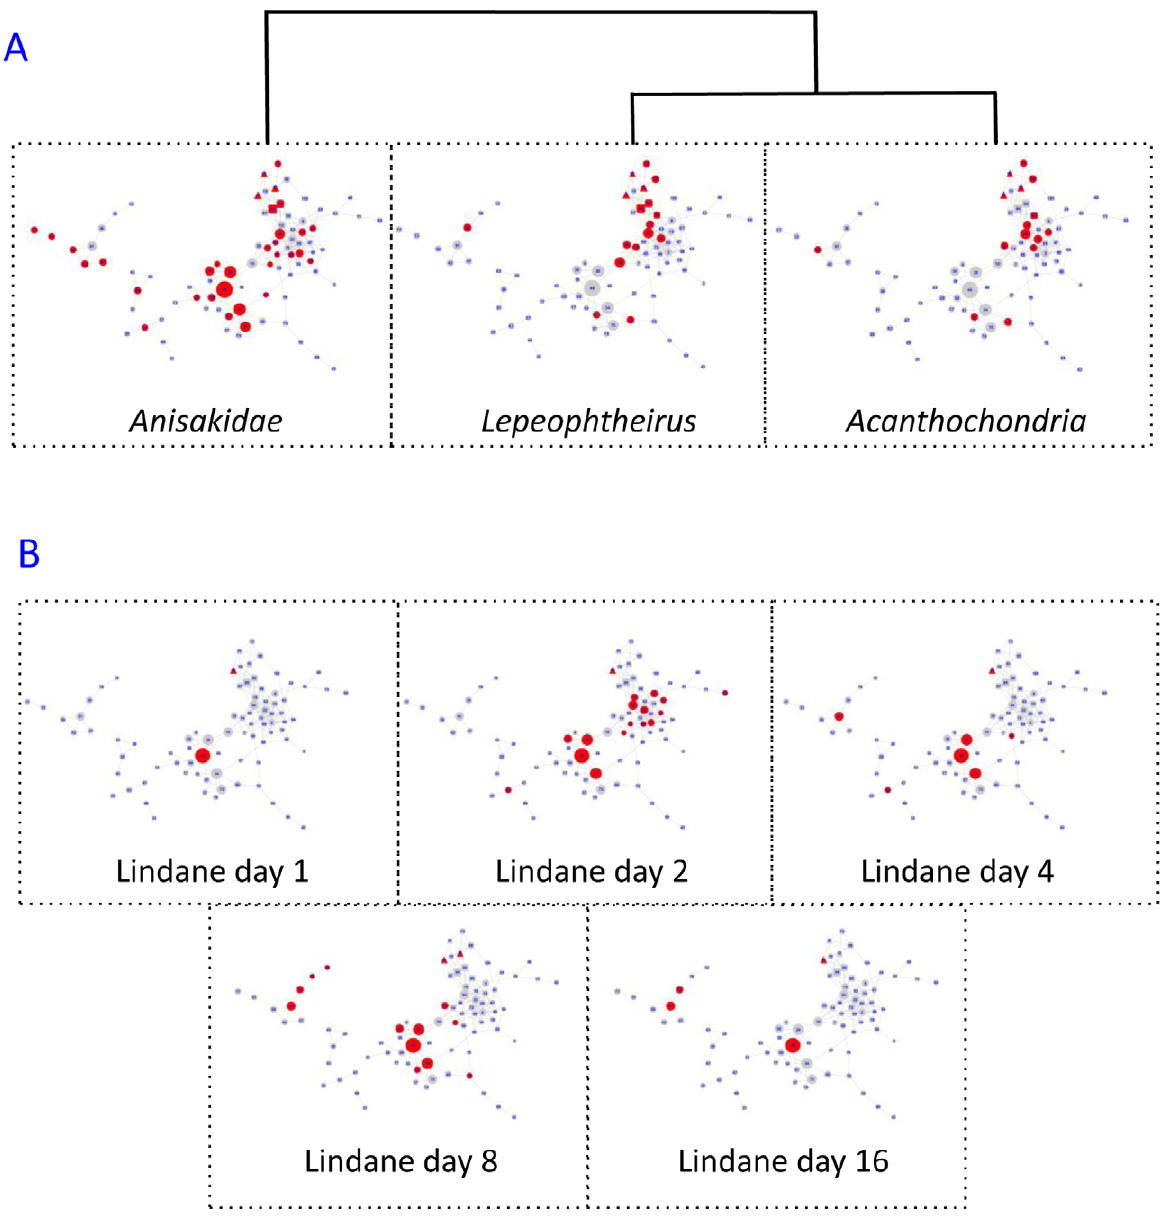
Figure 4. Modules overlapping with parasite infection and lindane treatment. A: Modules coloured red predict parasite infections using GALGO with a sensitivity and specificity of . 70%. Clustering of profiles is shown. B: Modules coloured red significantly overlap (Fisher’s Exact Test FDR , 0.05) with transcripts significantly altering (ANOVA FDR , 0.05, 2-fold change at each timepoint) in response to laboratory treatments of flounders with lindane over a 16-day time